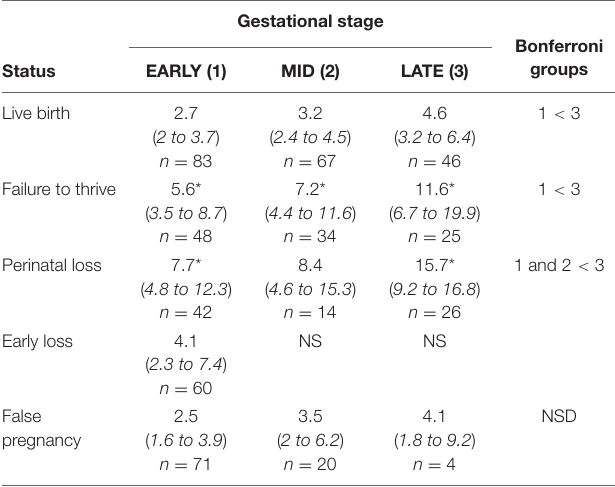
TABLE 4 | Marginal mean ( 95% CI ) cortisol concentrations (ng/ml) during each stage of normal (live birth) and abnormal bottlenose dolphin